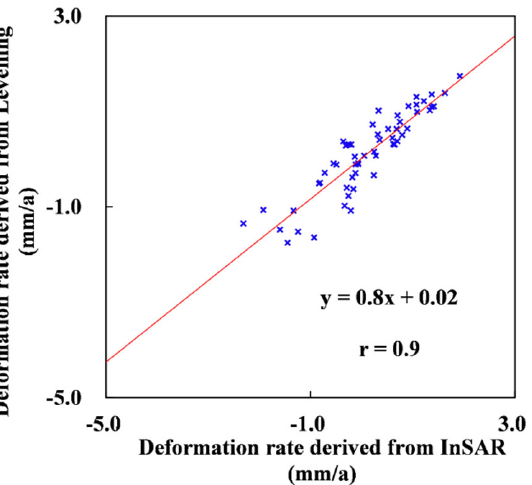
Figure 5. Comparison of the ground deformation rates derived from InSAR and levelling.